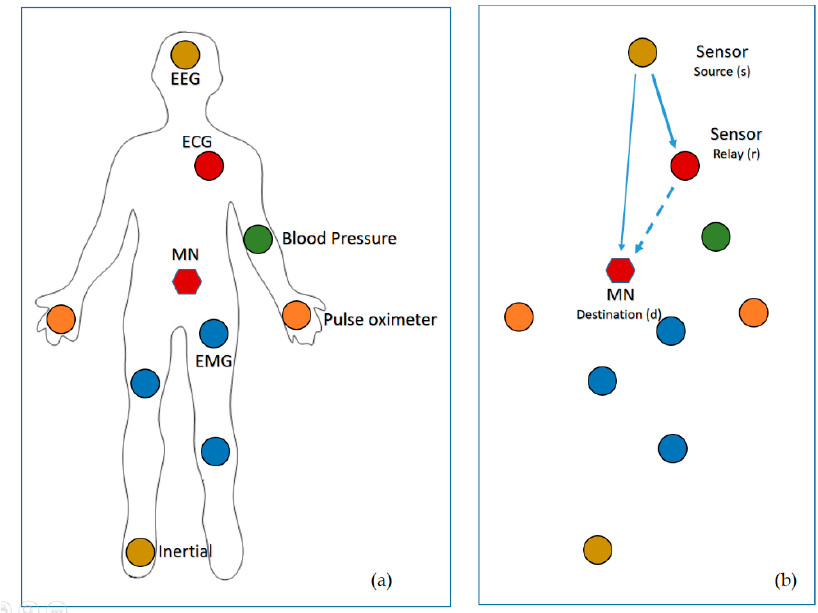
Figure 1. ( a ) Network architecture of WBAN; ( b ) Cooperative communication in WBAN.